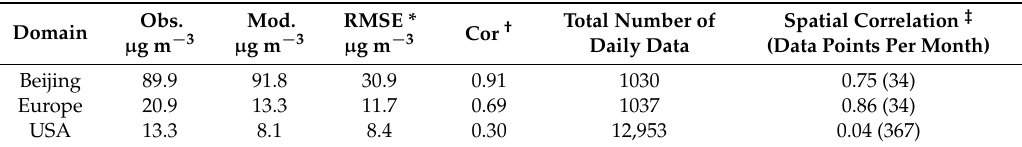
Table 1. Average performance of CHIMERE for PM 2.5 based on daily values in March 2014 over the Beijing area (all urban and rural background stations), USA (all background rural stations) and Europe (EMEP background rural